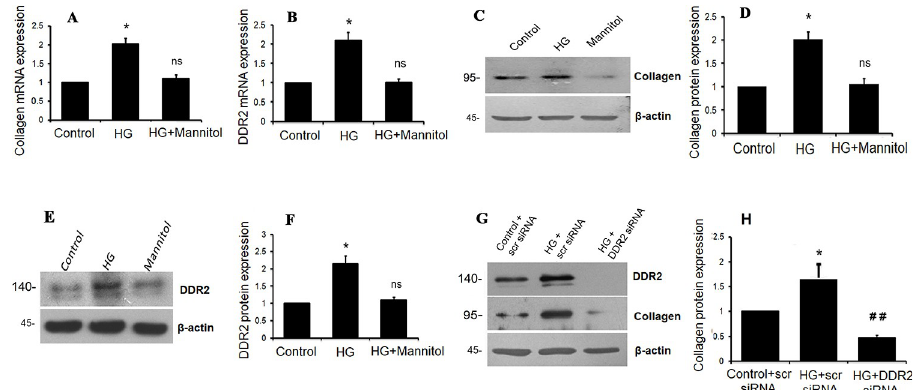
Fig 6. HG stimulates collagen type I and DDR2 in VSMCs. (A-F) Sub-confluent cultures of VSMCs in M199 were stimulated with HG (25mM). (A) Collagen type I alpha 1 mRNA levels were determined by Taqman real-time PCR at 12 h post-HG treatment, with 18S rRNA as loading control. � p < 0.05 vs. control, ns- not significant vs. control (One- way ANOVA p < 0.05). (B) DDR2 mRNA levels were determined at 12 h post-HG treatment. � p < 0.05 vs. control, ns- not significant vs. control (One-way ANOVA p < 0.05). (C and D) Collagen type I alpha 1 expression was determined by western blot analysis, with β -actin as loading control. � p < 0.05 vs. control, ns- not significant vs. control (One-way ANOVA p < 0.05). (E and F) DDR2 protein expression was determined by western blot analysis. � p < 0.05 vs. control, ns- not significant vs. control (One-way ANOVA p < 0.05). (G and H) Regulatory relationship between DDR2 and collagen type I in HG-treated VSMCs. VSMCs were transiently transfected with DDR2 siRNA or scrambled siRNA. Following exposure of the transfected cells to HG for 12 h, collagen type I alpha 1 protein expression was examined by western blot analysis. DDR2 knockdown using siRNA was validated. � p < 0.05 vs control, ## p < 0.01 vs HG. (One-way ANOVA p < 0.05).